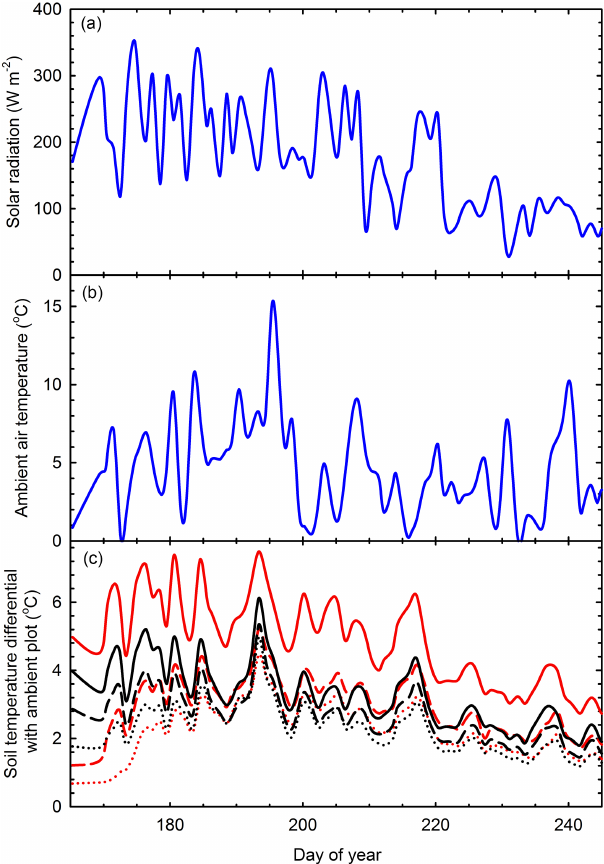
Figure 8. The influence of ambient (blue) solar radiation (a) and ambient air temperature (b) on soil temperature in the control (black, c ) and ZPW chambers (red, c ). Panel (c) shows the temper- ature differential between the chambers and the ambient plot. Soil temperature was measured at 5cm (solid line), 10cm (broken line) and 15cm (dotted line) below the base of the moss